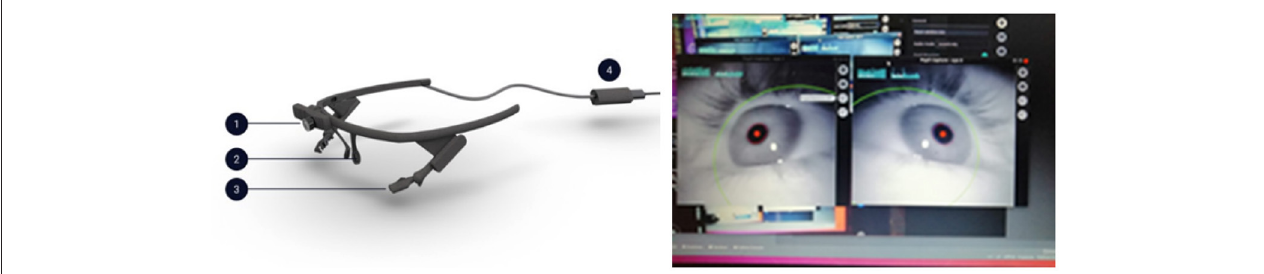
FIGURE 3 | Left : Pupil Core goggles. 1: front camera; 2 and 3: eye-oriented cameras; 4: cable connecting the goggles to the computer. Right : green framing around the eye image and red dot on the pupil image indicating that all cameras have been positioned